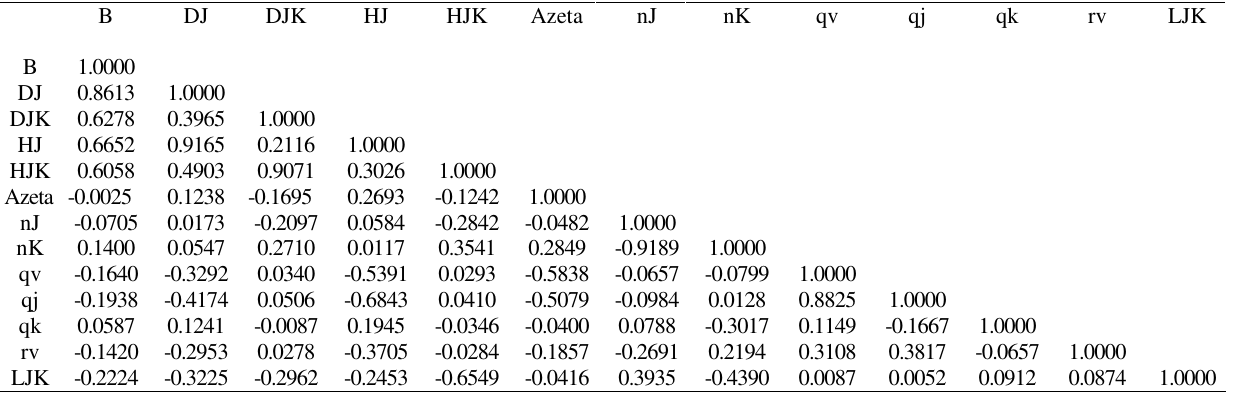
for the v = 1 3 4